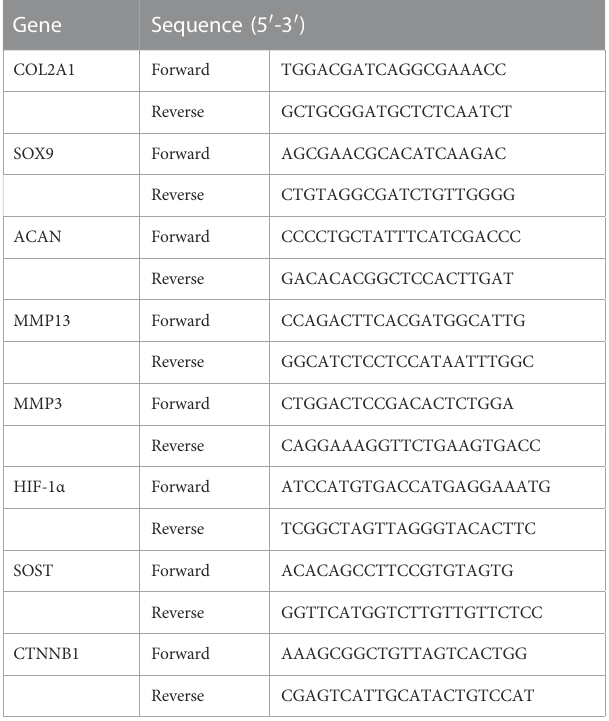
TABLE 1 Primer sequences used for quantitative real-time